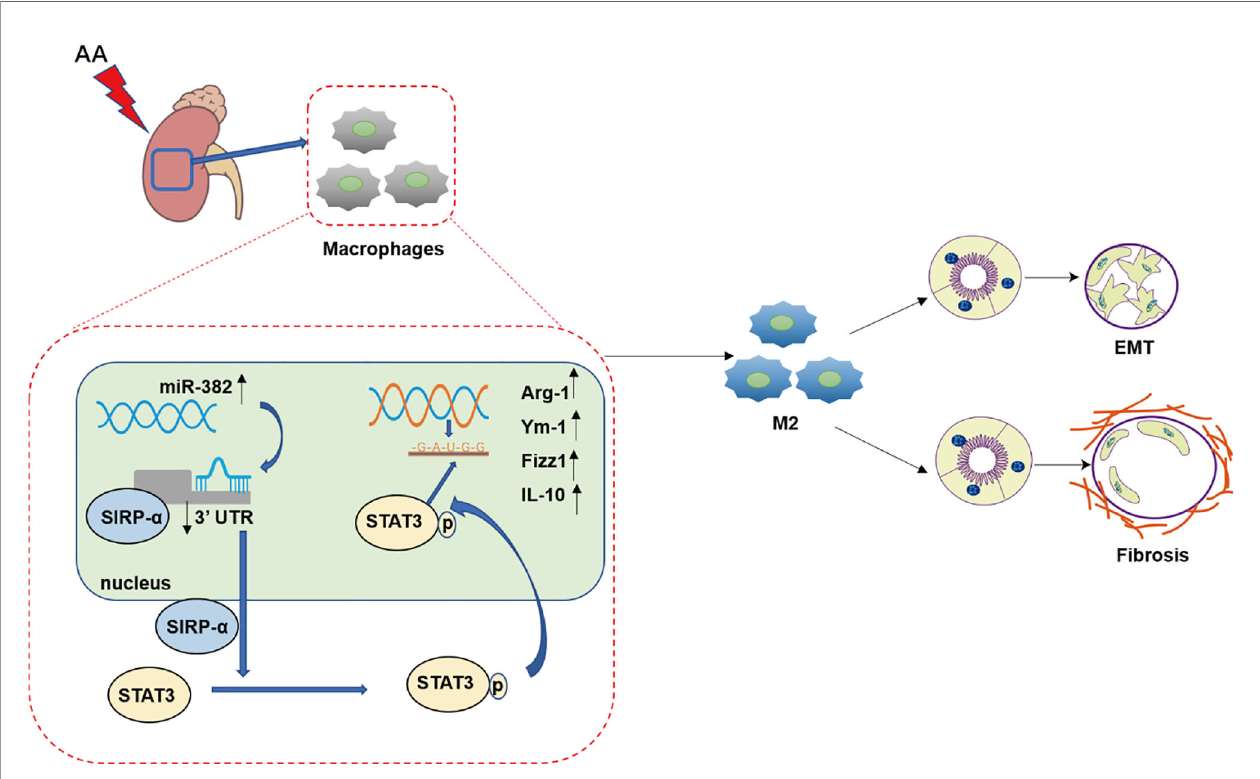
FIGURE 11 | Working model of this study. In the progression of aristolochic acid nephropathy, the expression of miR-382 in kidney macrophage increased signi fi cantly and then suppressed signal regulatory protein a (SIRP- a ) by combining 3 ′ UTR of SIRP- a . Then, downregulation of SIRP- a activated the signal transducer and activator of transcription 3 (STAT3) by promoting the phosphorylation of STAT3 at S727 and Y705. Phosphorylated STAT3 translocated into nucleic and acted as a transcription factor, which was responsible for M2-like macrophage activation. M2-like macrophage was involved in epithelial to mesenchymal transition (EMT) of renal tubular epithelial as well as pro- fi brotic effects in aristolochic acid-induced kidney fi